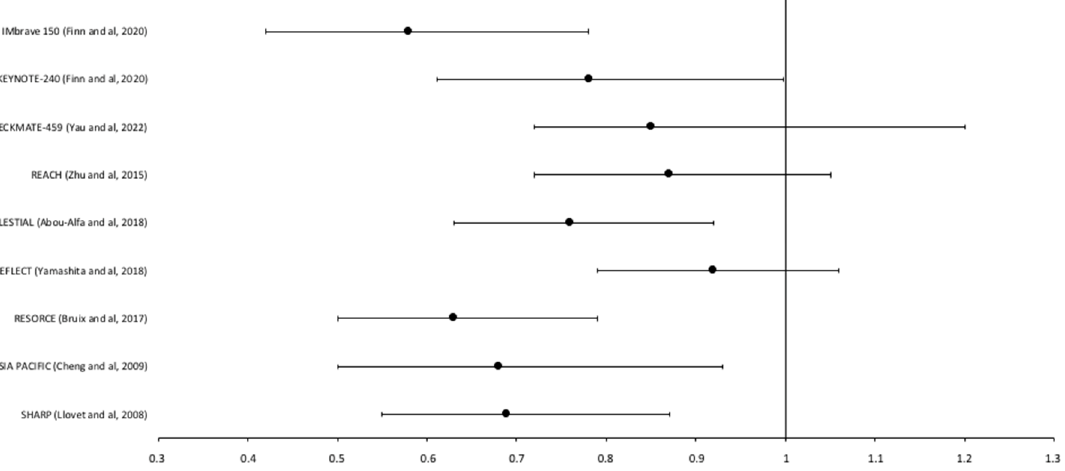
Figure 4. Forest plots of hazard ratio (HR) of overall survival (OS) in phase III-studies on advanced HCC [9,11–15,18,27,28].